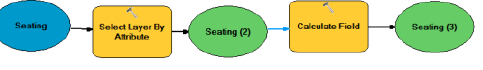
Figure 13: Assigning Picture Descriptor to Seat